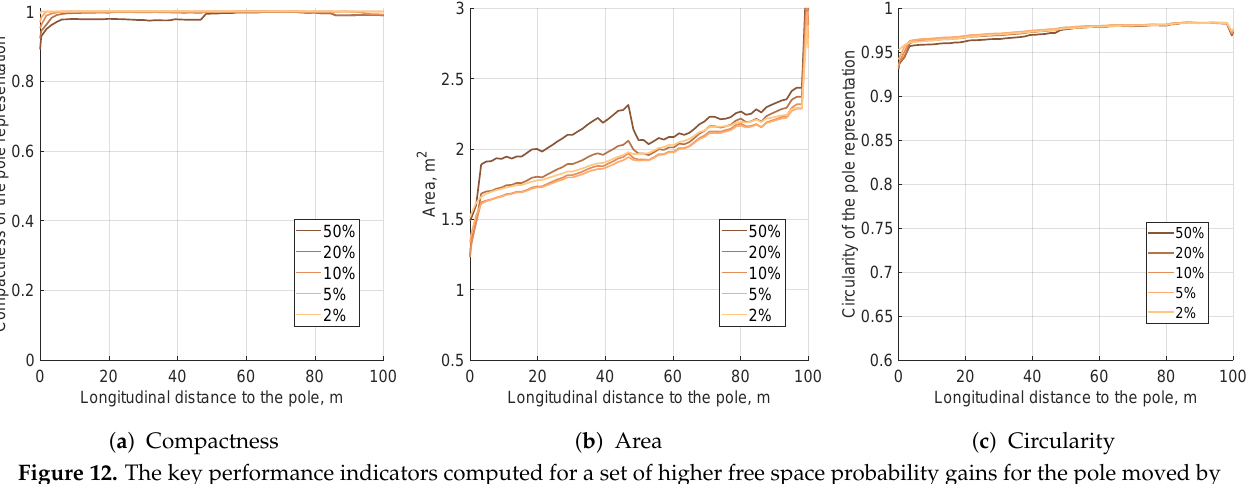
Figure 12. The key performance indicators computed for a set of higher free space probability gains for the pole moved by 10 m laterally per step with the application of a 2D Gaussian sensor model. The scaling of this figure is the same as that of all other simulation KPI